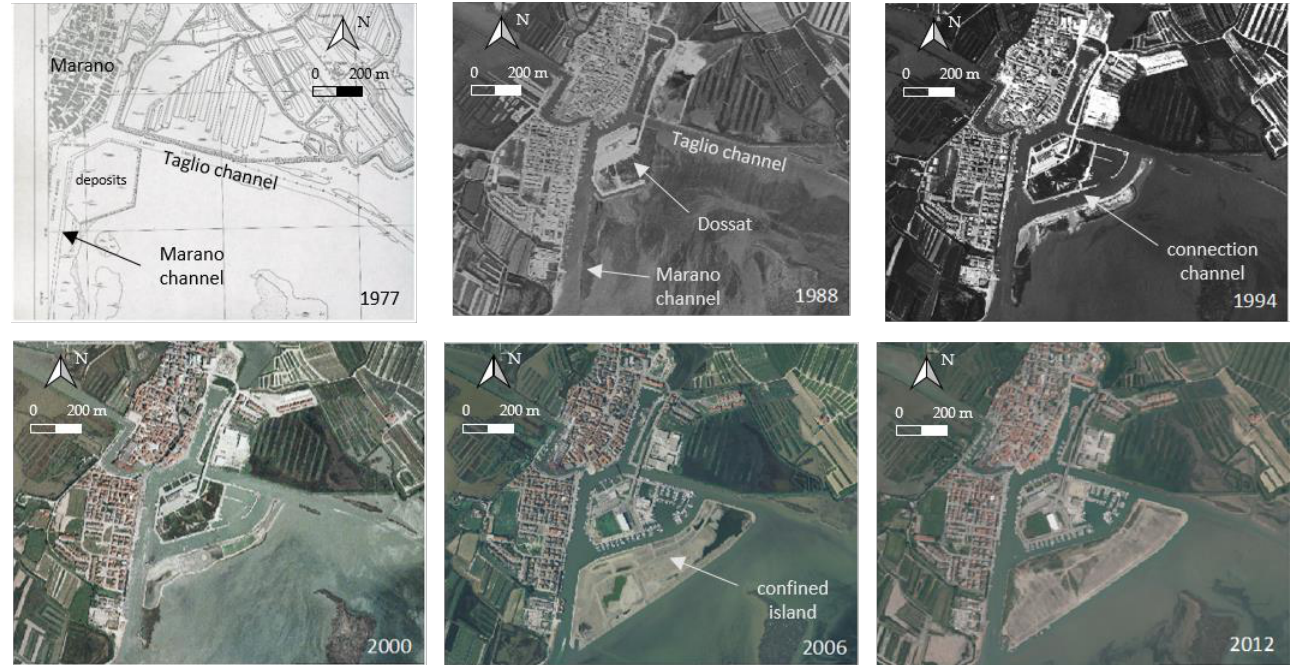
Figure 2. Historical evolution of the port of Marano Lagunare from 1977 to 2012 (red rectangle in Figure1b). The 1977 image is the regional cartography from 1977 (http://www.regione.fvg.it/rafvg/cms/RAFVG/ 01.09.2021); 1988–2012 images originate from the Italian National Geoportal of the Environment Ministry (http://www.pcn.minambiente.it/mattm/ 18.08.2021).